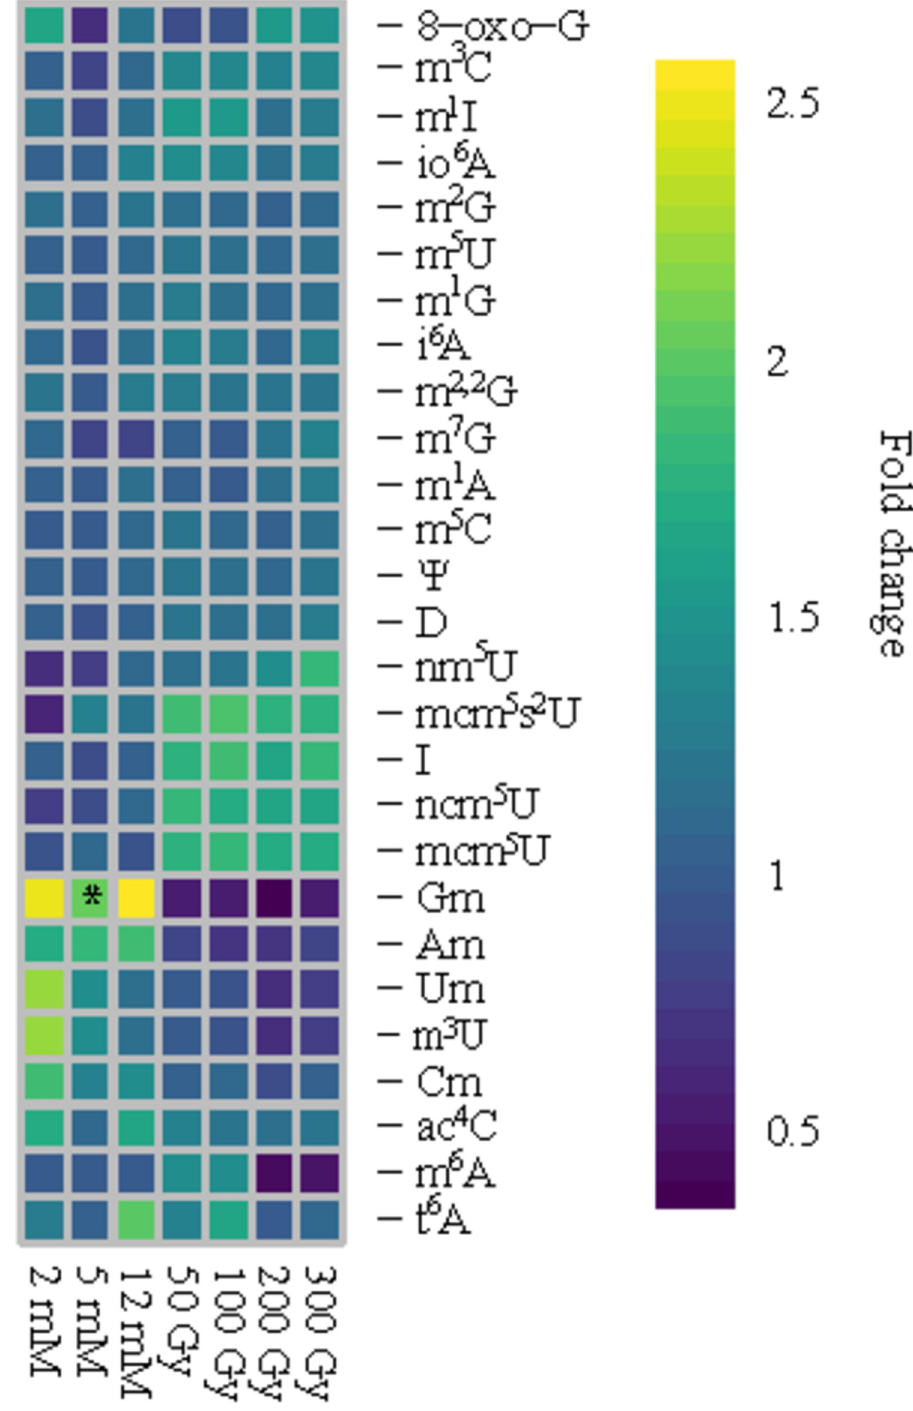
Fig 2. Modification abundances are largely unaffected by oxidative conditions. Heatmap of the fold change of the normalized relative abundance for the nucleosides detected in C . neoformans . The concentrations of H 2 O 2 are 2 mM, 5 mM, and 12 mM while IR doses consisted of 50 Gy, 100 Gy, 200 Gy, and 300 Gy. The average fold change of three replicates is plotted in the heatmap. A fold change cutoff of 2 and a Student’s t-test p-value < 0.05 were considered